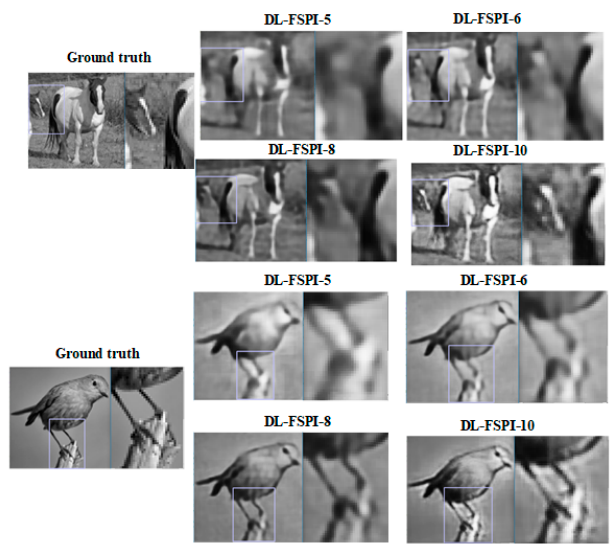
Figure 6. Background and low-level feature reconstruction for different DL-FSPI models.